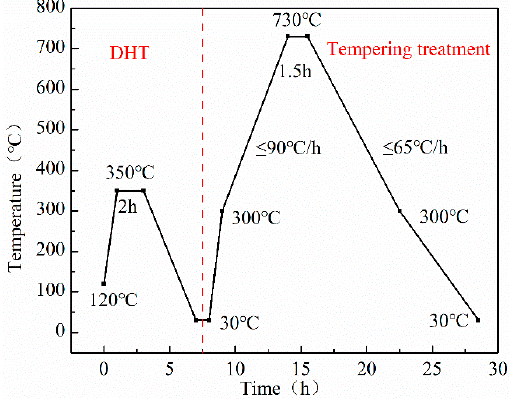
Figure 4. Thermal cycle curve of post-weld heat